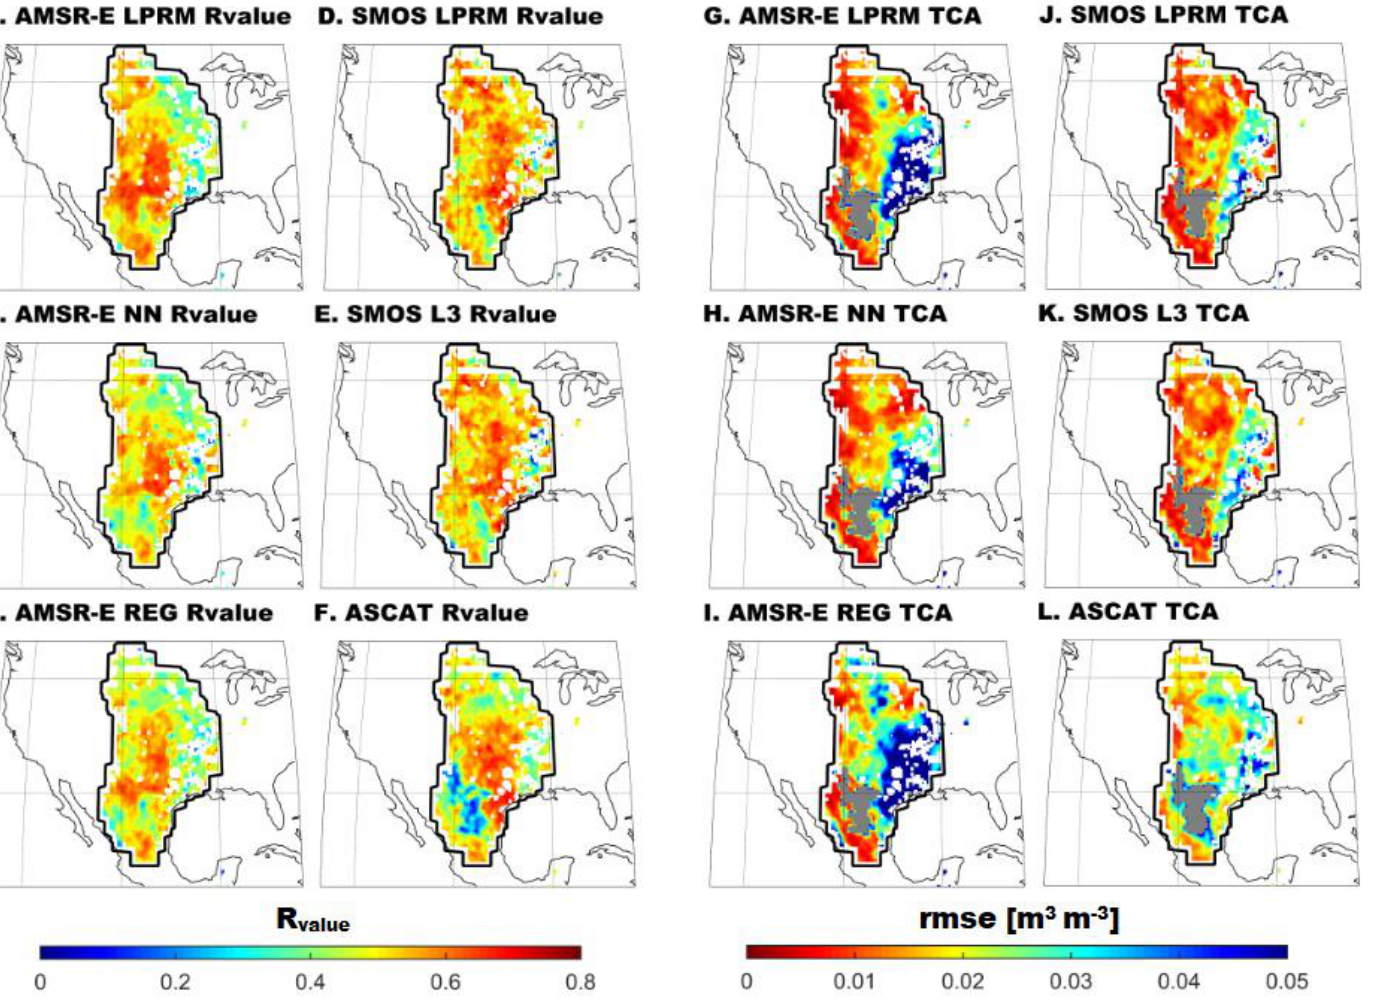
Figure 6. R value ( A – F ) and TCA ( G – L ) results over the central Great Plains of North America. The Chihuahuan Desert is masked out (gray) in the TCA results.